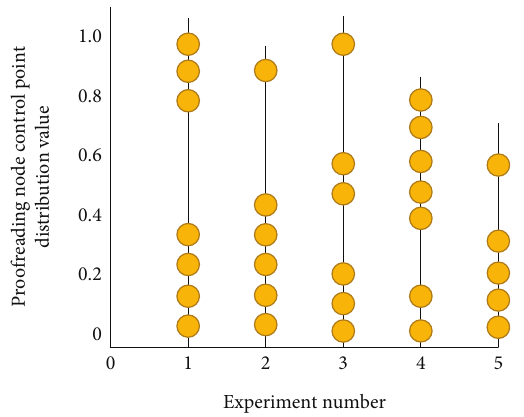
Figure 7: Distribution of node control points of this method on the calibration